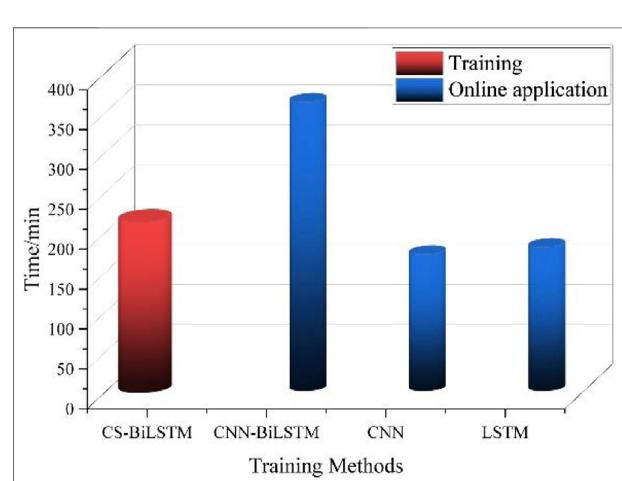
FIGURE 8 | Training loss and classi fi cation accuracy of CS- BiLSTM model.